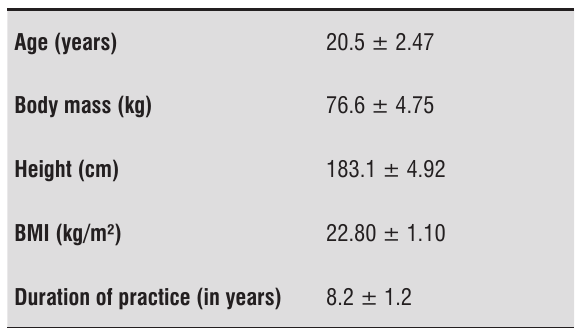
Table 1 - Characteristics of the study participants (n =